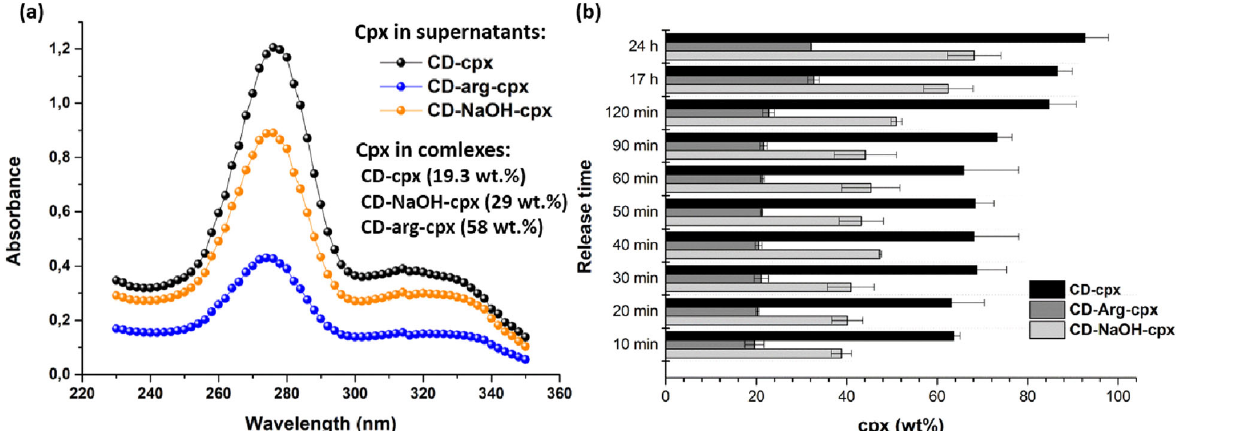
Fig. 5 Cipro fl oxacin (cpx) contents in complexes and its release. Cpx in supernatants obtained after complex synthesis (and calculated contents of cpx in β CD complexes) (drug released from CD-arg-Cpx complex indicated with blue, from CD-NaOH-Cpx complex in orange and from CD-Cpx in black) ( a ) and comparative drug release kinetics from β CD-cpx (black), β CD-arg-cpx (dark grey) and β CD-NaOH-cpx (lith grey) ( b ); n = 3; error bars refer to SD of drug release. Table 1 Minimal inhibitory concentrations (MICs) of β CD and its complexes against gram-positive and gram-negative bacterial strains, their cytotoxicity to mammalian cells and their selectivity indices. E. coli